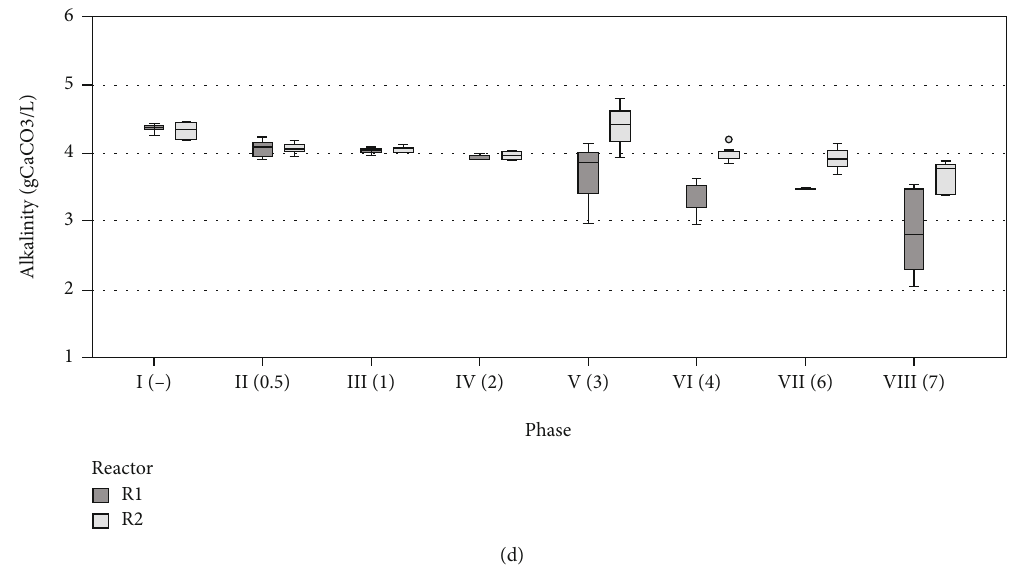
/CO ratio): (a) box plots of 2 2